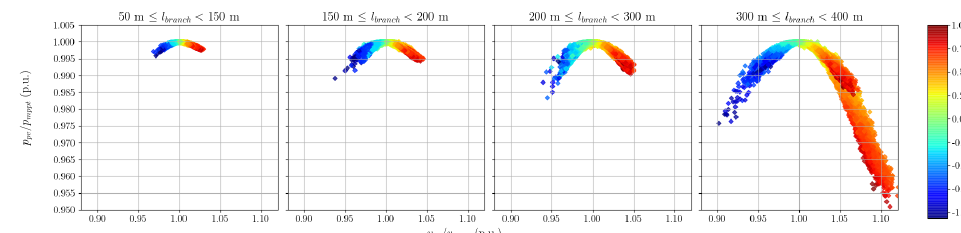
Figure 4. Voltage variation ( V pv ) on the DC-branch and impact on the curtailed production ( P pv ) as a function of the produced (positive) and consumed (negative) power.